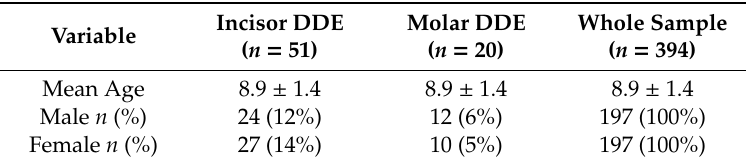
Table 1. Age and gender